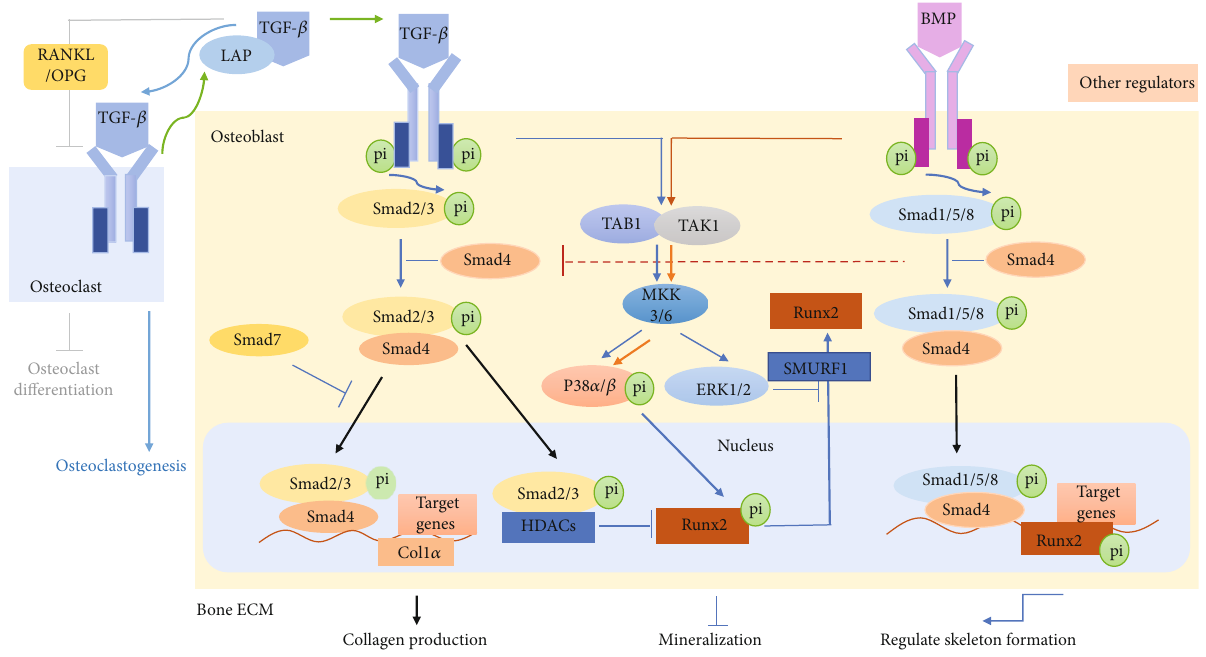
Figure 4: The main regulatory pathways of TGF- β and BMP in bone ECM. TGF- β is produced predominantly by osteoblasts and deposited into the matrix with LAP. Activated TGF- β requires osteoclastic bone resorption by dislodging LAP [67]. Smad2/3 is phosphorylated and connects with Smad4 when TGF- β combines with its receptors. The complex of Smad2/3 with Smad4 could transport into the upstream of Col1 α and into other target gene transcription start sites. The complex upregulates gene expressions to promote collagen production [68, 69], and it is inhibited by Smad7. The phosphorylated Smad2/3 could inhibit the expression of Runx2 by combining with HDACs [70]. On the other hand, TGF- β in fl uences Runx2 expression to suppress bone mineralization and osteogenesis by the MAPK pathway, independent of Smad3. The p38 MAPK pathway directly regulates the expression of Runx2. And the MAPK-ERK pathway reduces the expression of Runx2 by upregulating SMAD ubiquitination regulatory factor 1 (SMURF1) [71, 72]. BMP could improve the expression of Runx2 by Smad1/5/8 and Smad4 or the p38 MAPK pathway for regulating skeleton formation [75, 76]. And the process of the combination of Smad4 could suppress the formation of the Smad2/Smad3/Smad4 complex. TGF- β : transforming growth factor β ; HDACs: histone deacetylases; ERK1/2: extracellular signal-regulated kinase 1/2; MKK: mitogen-activated protein kinase kinase; TAK1: transforming growth factor-activated kinase 1; SMURF1: SMAD ubiquitination regulatory factor 1; BMP: bone morphogenetic protein; LAP: latency-associated protein; RANKL: receptor activator of nuclear factor kappa B